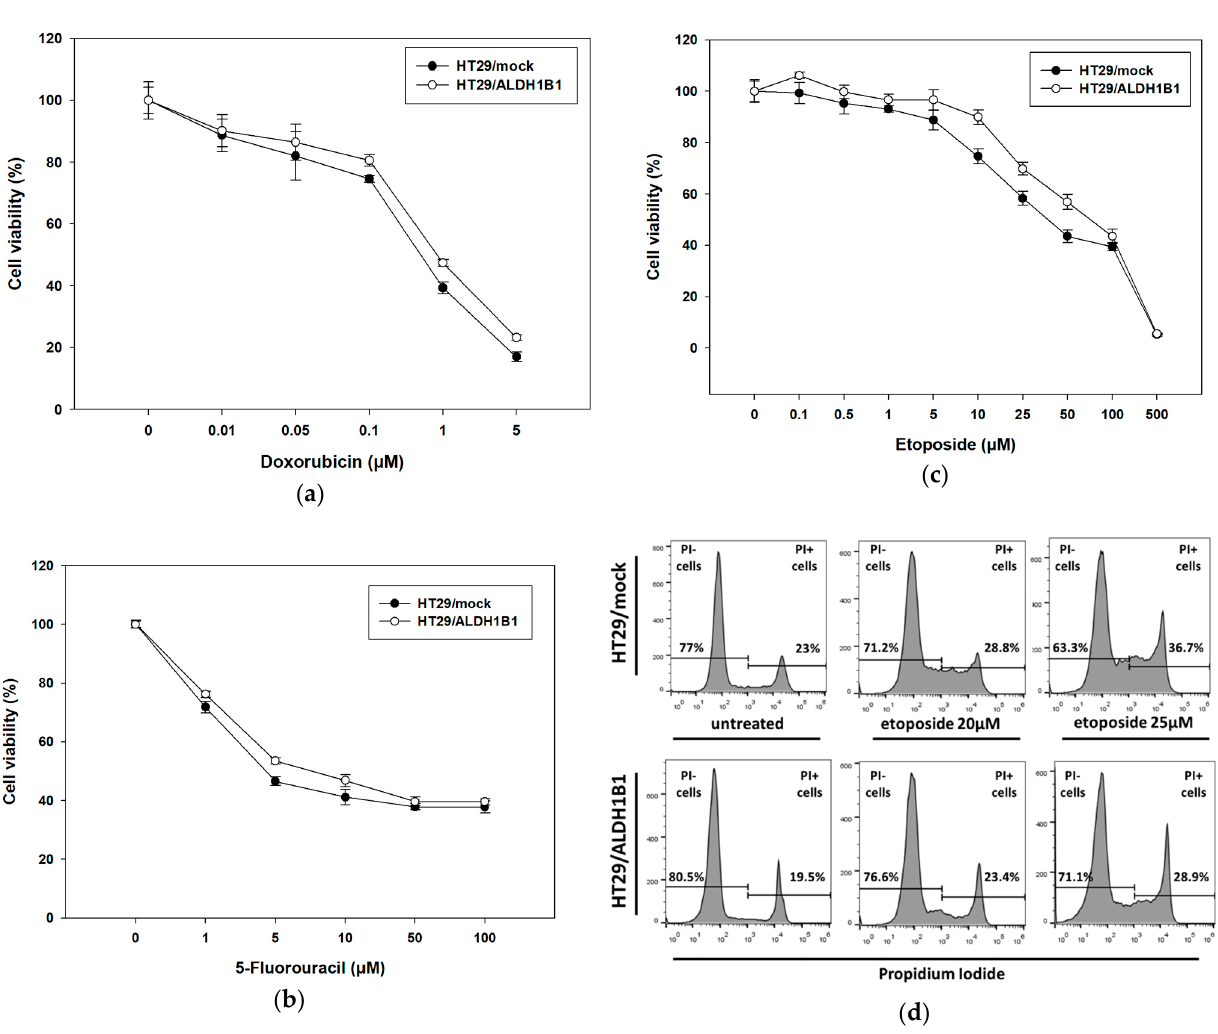
Figure 5. Effects of various chemotherapeutic agents on the cell viability of HT29/mock and HT29/ALDH1B1 cells. Viability curves of HT29/mock and HT29/ALDH1B1 cells after exposure to ( a ) doxorubicin, ( b ) 5-fluorouracil and ( c ) etoposide for 72 h ( a , b ) and 48 h ( c ). Viability curves of the HT29/ALDH1B1 cells are shifted to the right, indicating increased cellular tolerance to the cytotoxic effect of the agents. ( d ) Cells (1.5 × 10 6 ) were seeded in 10-cm culture plates and treated with etoposide for 48 h. After washing, cells were stained with propidium iodide (PI) and analyzed by flow cytometry for the assessing % of dead cells. At least three independent experiments were performed under each experimental condi- tion. Table 6. Percentage (%) of unstained and propidium iodide (PI)-stained cells under normal and etoposide conditions.